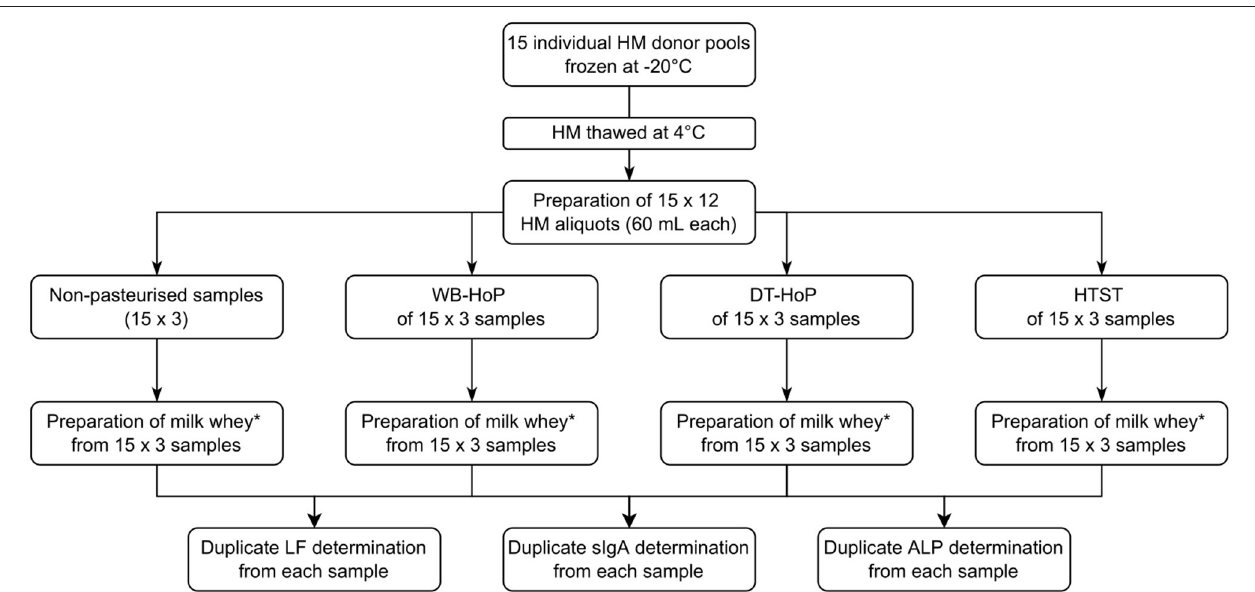
FIGURE 1 | Study flowchart. HM, human milk; DT-HoP, dry-tempering Holder pasteurization; WB-HoP, water-bath pasteurization; HTST, high-temperature short-time treatment; ALP, alkaline phosphatase; sIgA, secretory immunoglobulin A; LF, lactoferrin. * Preparation of milk whey: From samples 10mL aliquots were centrifuged at 600g for 10min, the resulting aqueous layer was again centrifuged at 600g for 10min and the resulting whey supernatant was centrifuged at 2,500g for 10min and the resultant supernatant was then filtrated with a 0.45 µ m with syringe filter.